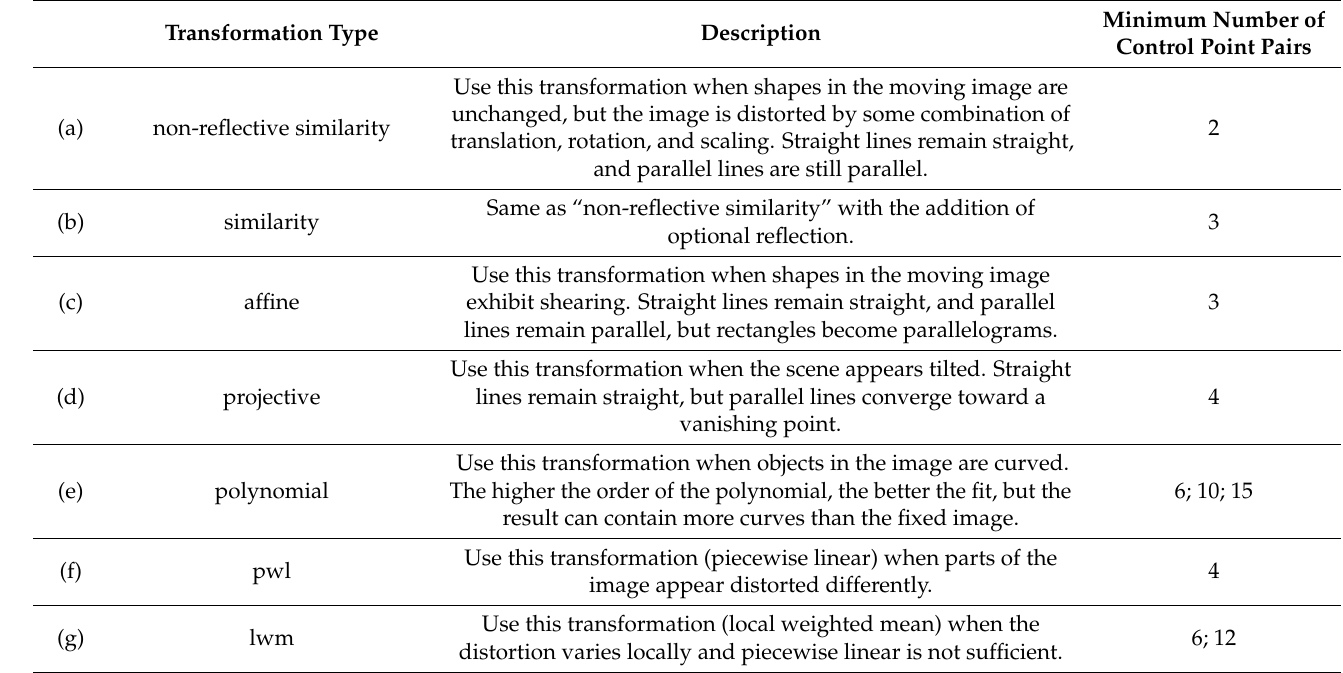
Table 1. Transformation types supported by fitgeotrans in order of complexity [19].